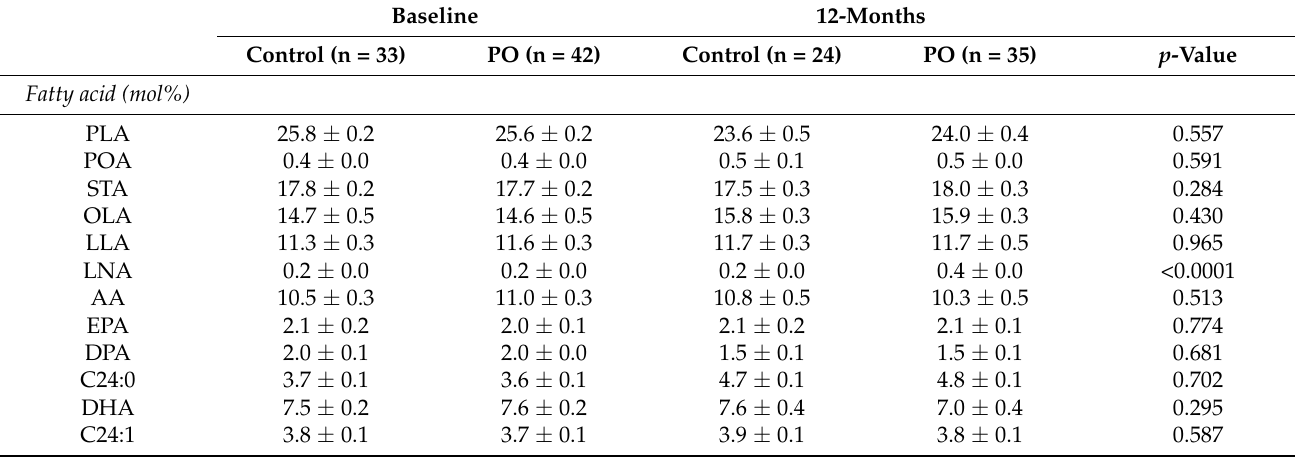
Table 5. Fatty acid profile of the red-blood cell plasma membranes at baseline and after 12 months of intervention. Baseline